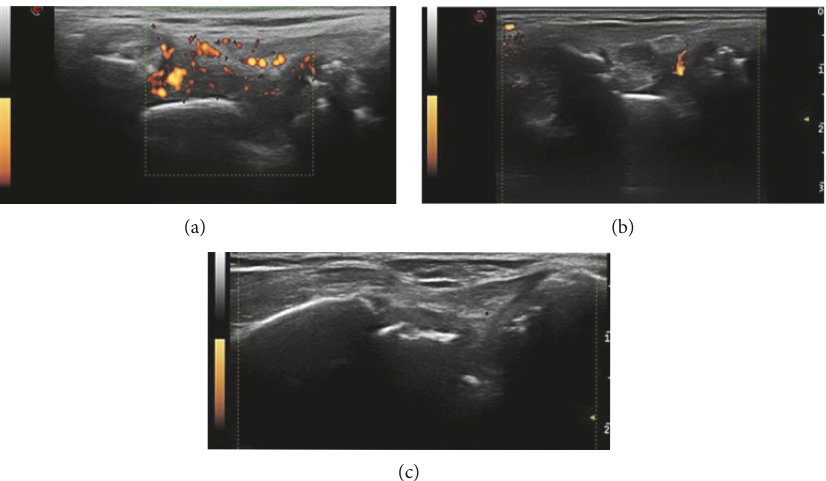
Figure 1: Serial changes after adalimumab therapy at radio-lunate joint (a) baseline (0 month, SH grade 3, SV grade 3), (b) one month (SH grade 3, SV grade 1), and (c) three months after (SH grade 1, SV grade 0). Power Doppler synovitis decreased dramatically on the fi rst month, while gray scale synovitis decreased from the third